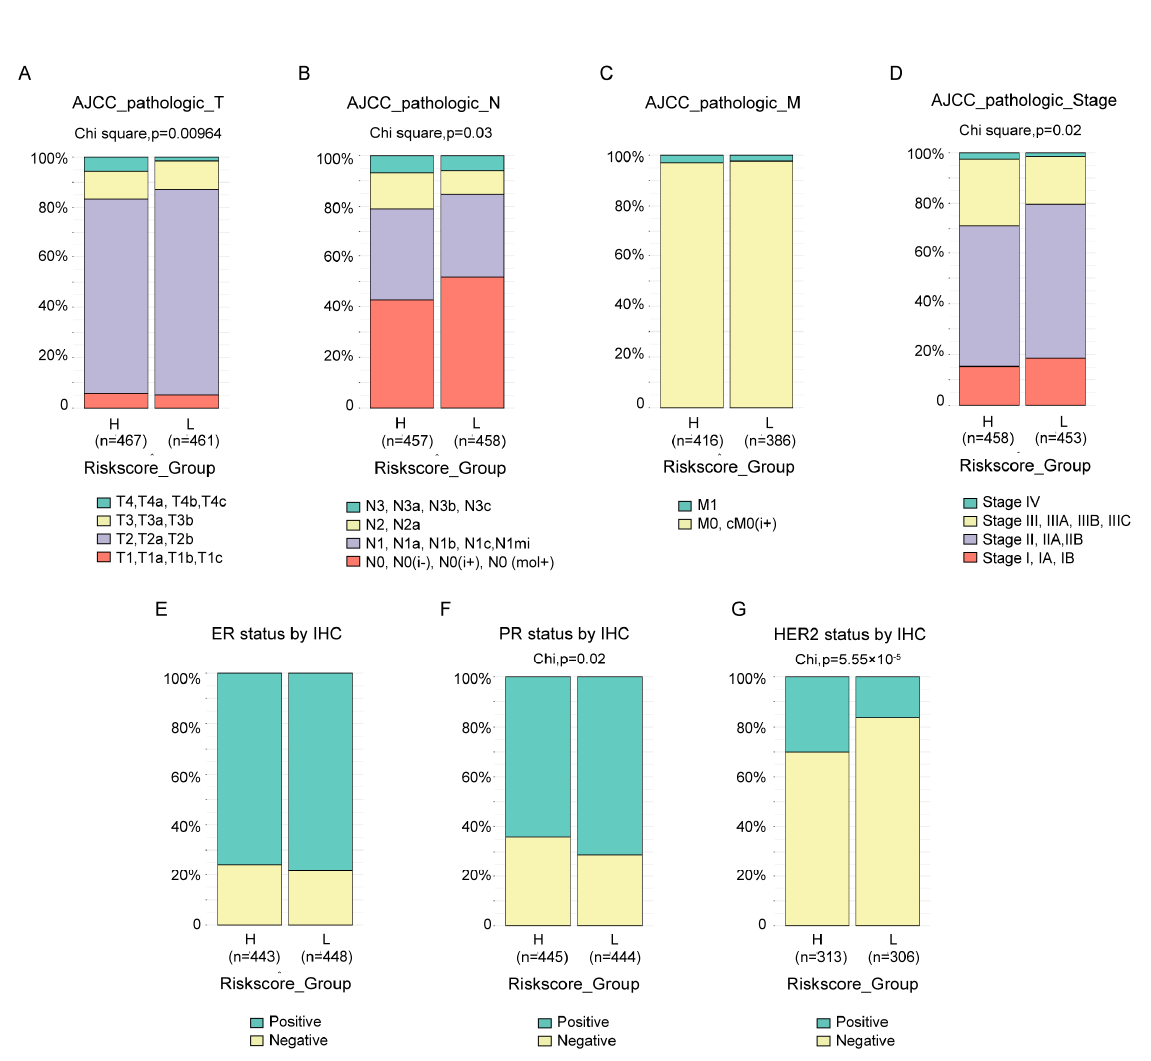
Figure 5. Association between the risk score and clinical features. The difference in the AJCC pathologic T ( A ), N ( B ), M ( C ), stage ( D ) status, ER status by IHC ( E ), PR status by IHC ( F ) and HER2 status by IHC ( G ) between high- and low-risk score groups in the TCGA-BRCA cohort were compared by chi-square test.